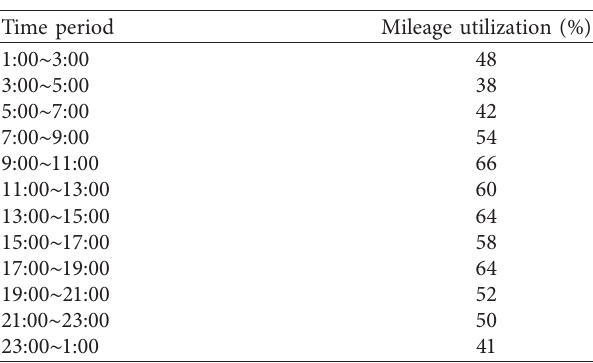
Table 10: Mileage utilization at different time periods of the op- erating day.